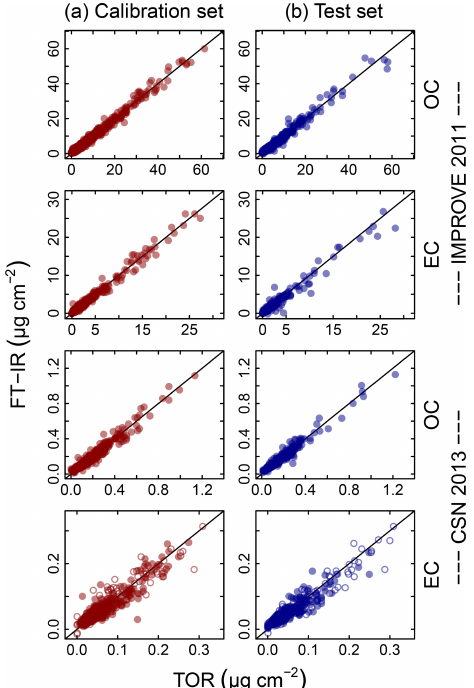
Figure 4. Illustration of model fits (“Calibration set”, column a ) and predictions (“Test set”, column b ) for the 2011 IMPROVE and 2013 CSN networks. Open circles for CSN EC indicate anomalous sam- ples (discussed in Sect. 3.5.3). Note units are in areal mass density on the filter.